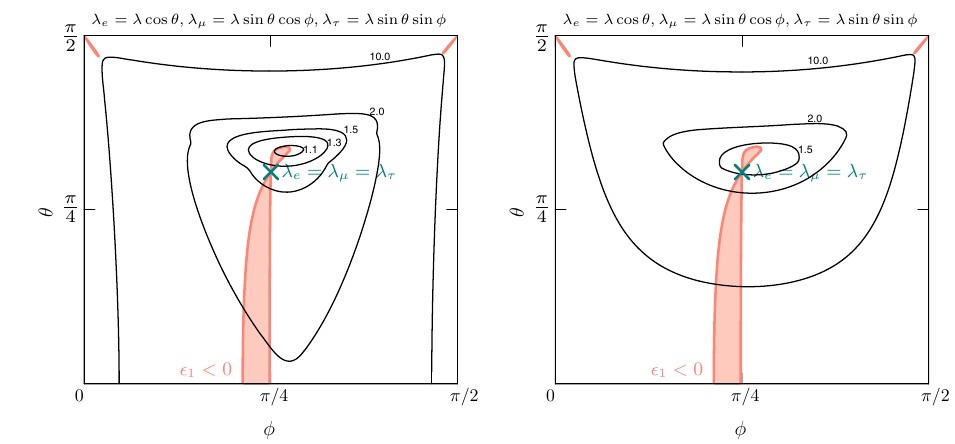
Fig. 6 The sign of the asymmetry parameter (cid:13) 1 and contours of the right-handed neutrino-mass ratios M 2 / M 1 (left) and M 3 / M 1 (right) in the (θ,φ) plane,wheretheneutrinoYukawacouplingsareparametrized as (λ e ,λ μ ,λ τ ) = λ( cos θ, sin θ cos φ, sin θ sin φ) . The input oscilla-